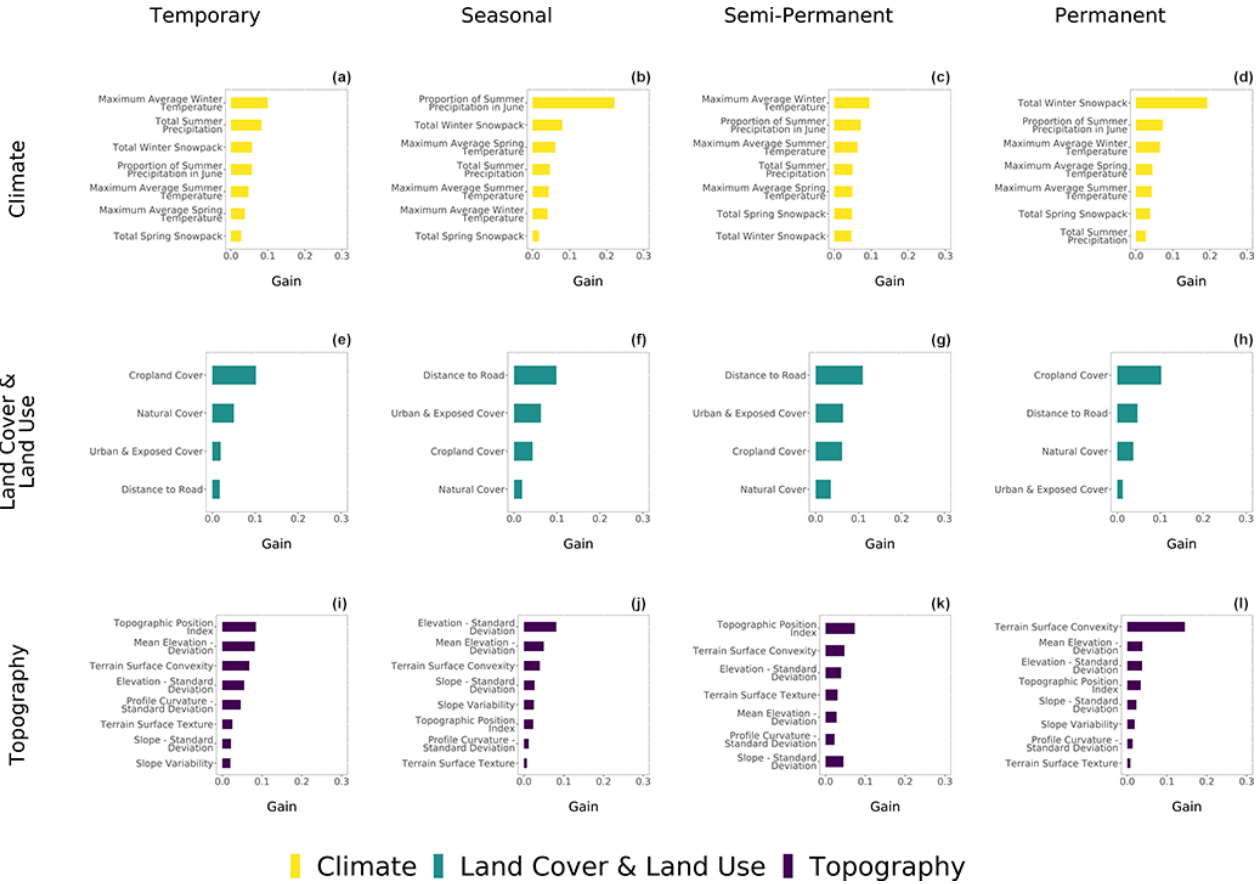
Figure F1. Variables ranked by their importance in the extreme gradient boosting models for wetlands delineated in the Parkland Natural Region (totalling 12000 wetlands) by permanence class. These variables were proxies for climate (a–d) , land cover and land use (e–h) , and topography roughness (i–l) . The gains illustrate the relative contribution of each variable in the model – the higher the value, the greater the